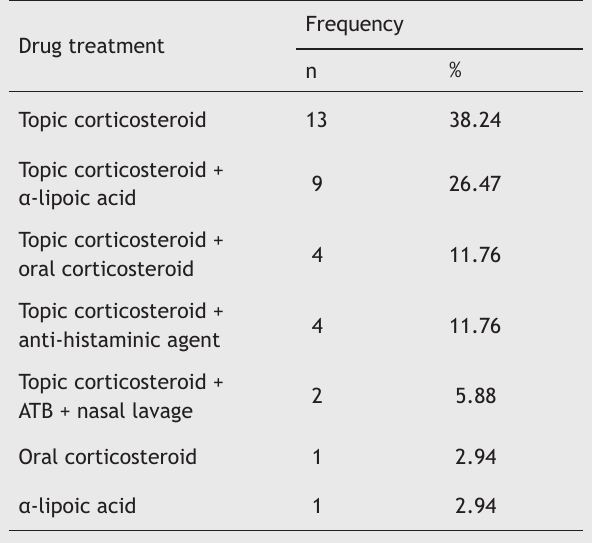
Table 5 Drug treatment prescribed to patients. Drug treatment